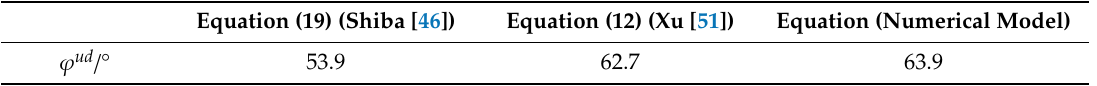
Table 6. Comparison of ϕ ud from di ff erent models.